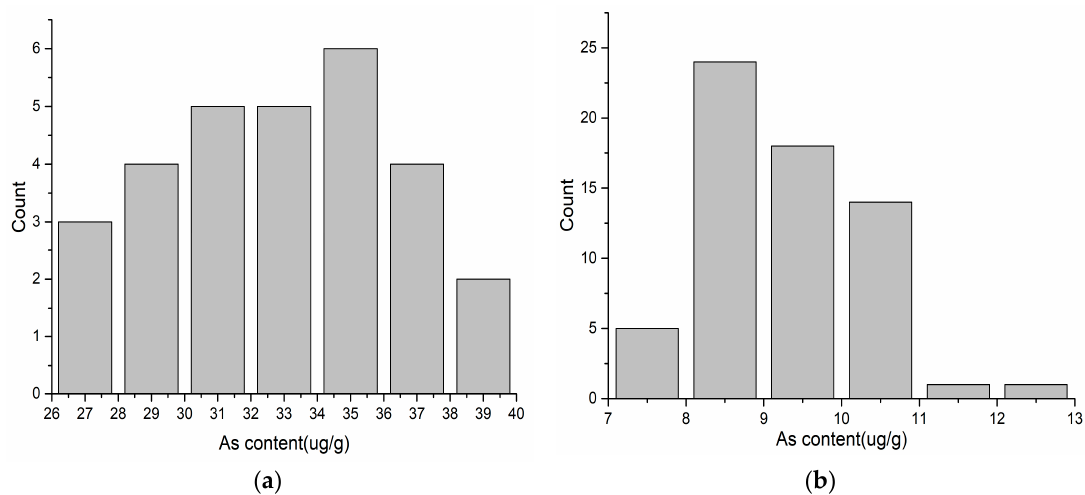
Figure 3. Histograms of the As concentrations of the soil samples. ( a ) Soil samples from Honghu. ( b ) Soil samples from Daye.